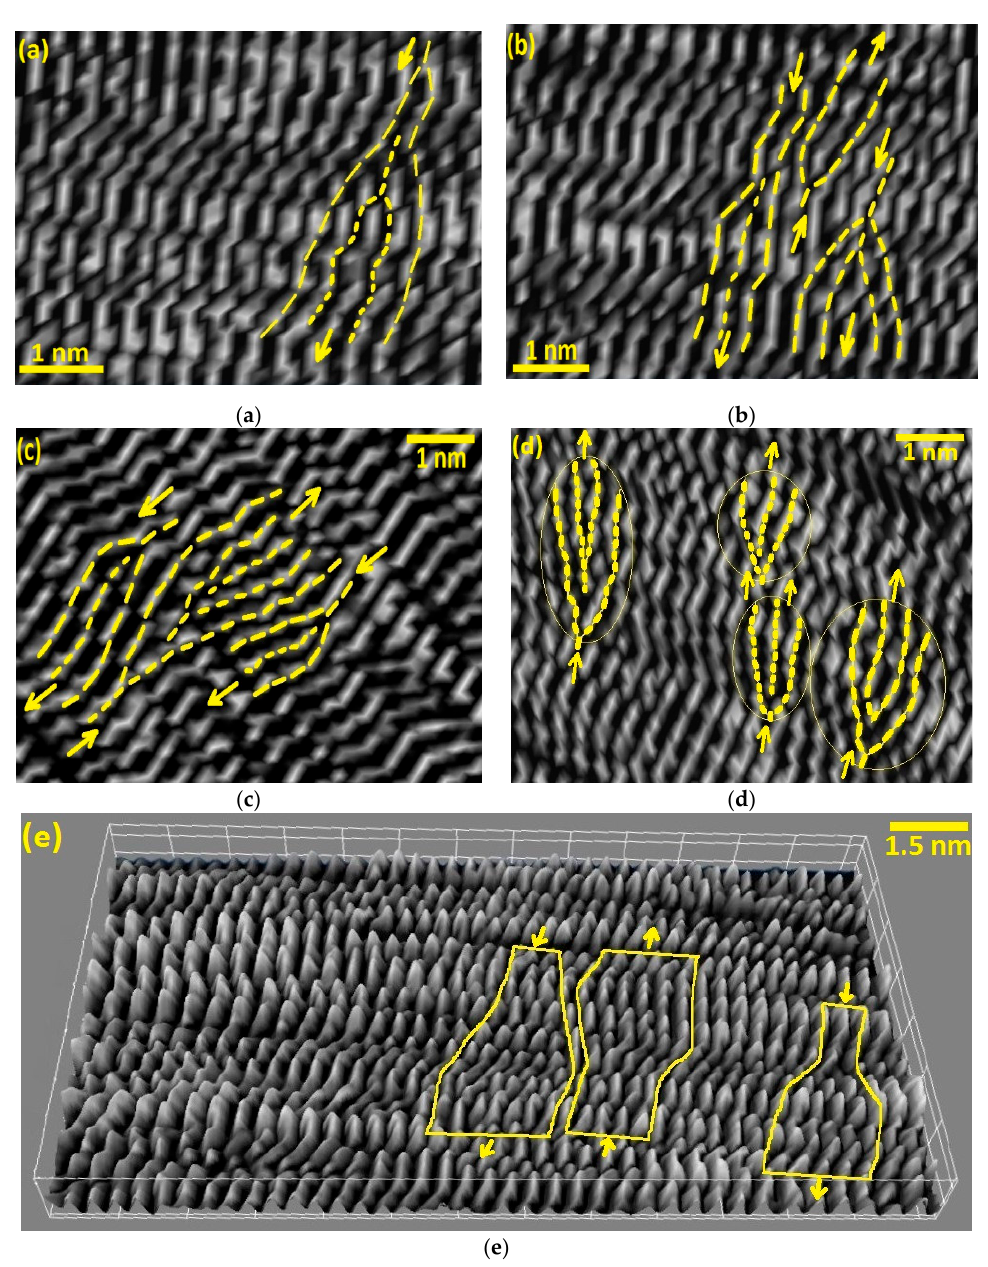
Figure 5. Stripped patterns of the crystalline lattice of AA6082-T6 BFSW weld; ( a – e ) The landmarks indicates some of edge dislocations between the lattice planes (crystal layers), in different regions of the weld; ( a ) BM, ( b ) HAZ, ( c ) TMAZ, ( d ) Hourglass-border of SZ. ( e ) AFM map with very high resolution crystal structure with corresponding edge Dislocations (mid-SZ).